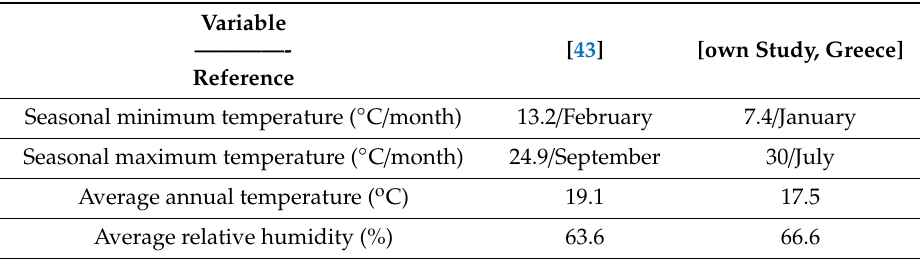
Table 2. Indoor temperature and relative humidity